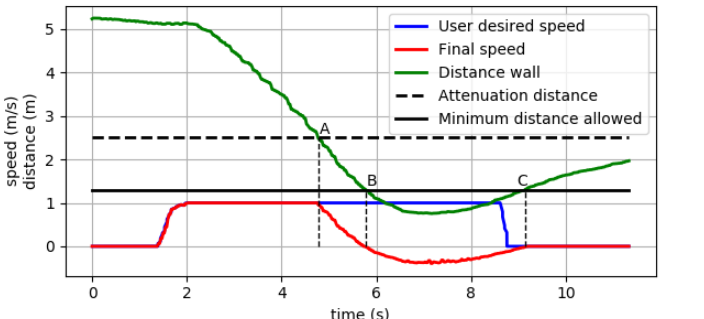
Figure 9. Performance of the behaviours related with collision avoidance.